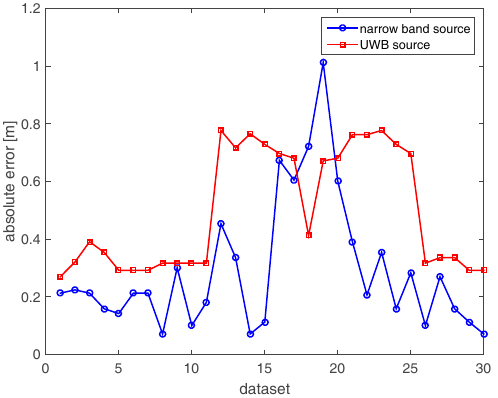
Figure 17. Positioning errors achieved with additive-array image fusion (D).